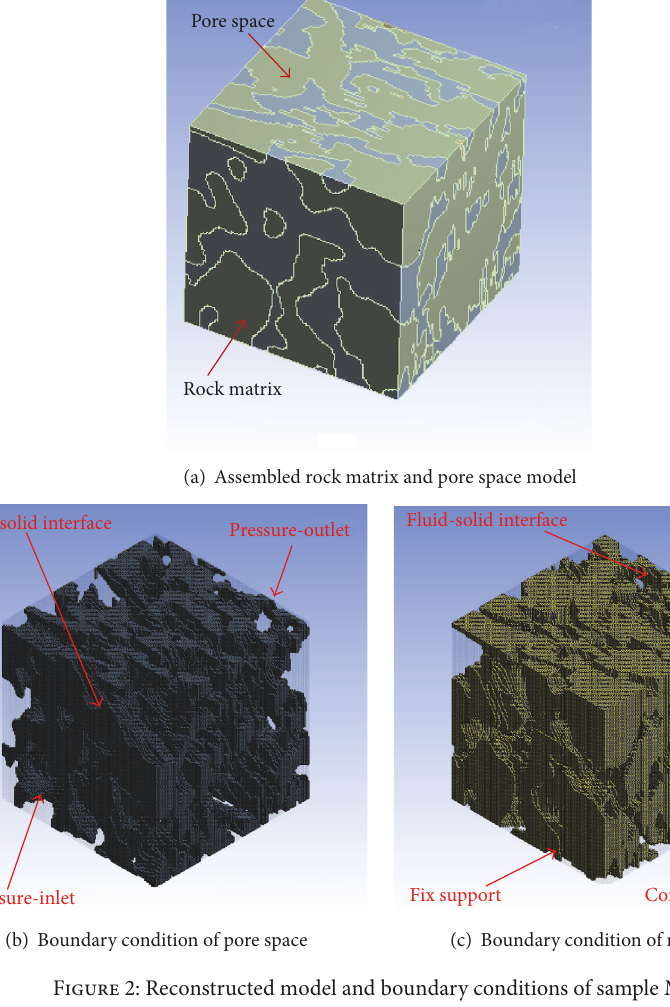
Figure 2: Reconstructed model and boundary conditions of sample MS1.